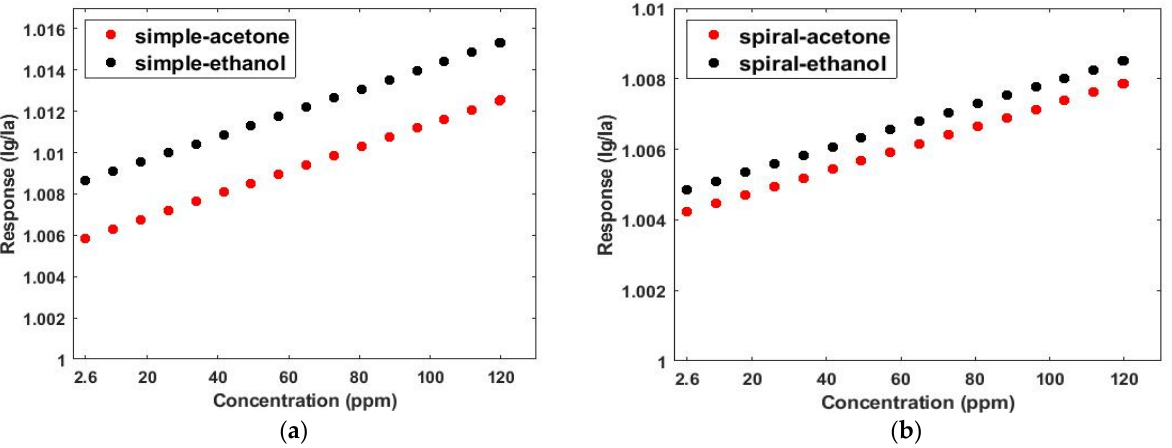
Figure 8. The relationship between the gas response of each model and the concentration of acetone and ethanol at room temperature: ( a ) simple model and ( b ) serpentine model.